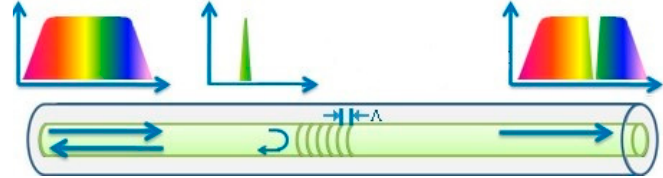
Figure 3. Schematic diagram of fiber grating.